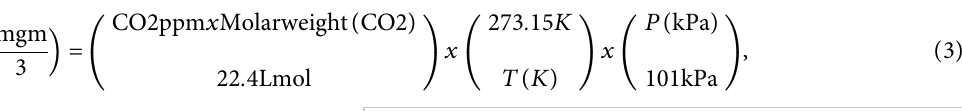
2 chamber to measure CO 2 emission